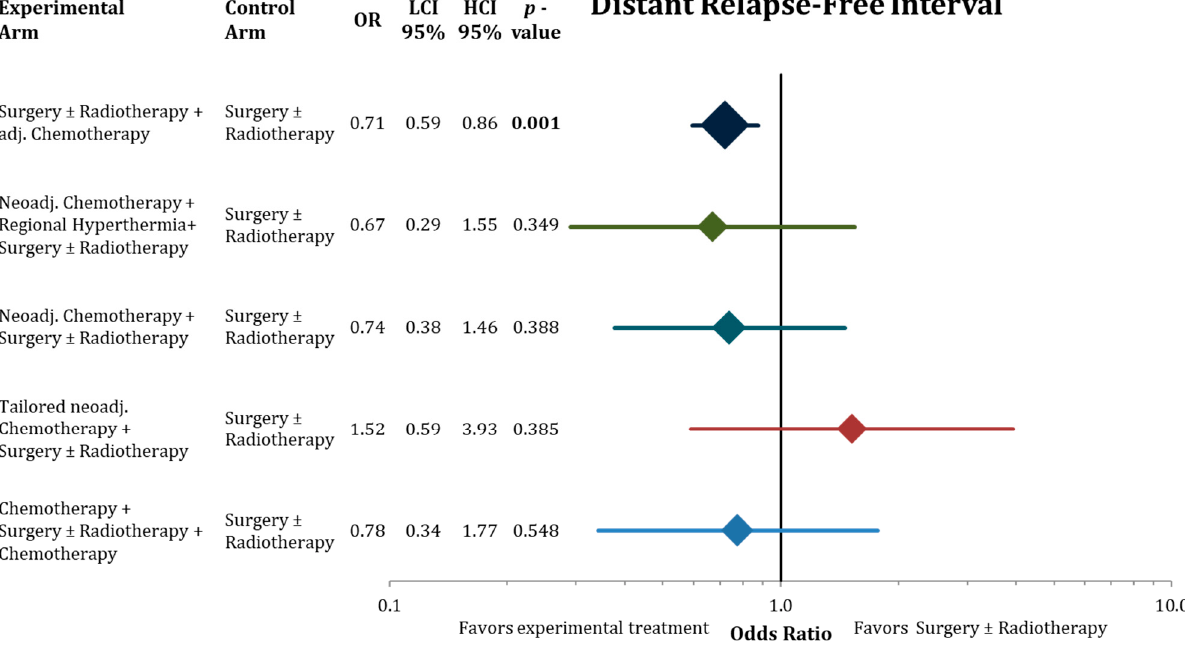
Figure 6. Forest plot comparing distant relapse-free interval in the network analysis of the experimental treatments against surgery ± radiation therapy. Hazard ratios with lower and higher 95% confidence interval and the corre- sponding p -values are presented. The sizes of the diamonds are proportional to the weights in the meta-analysis. HR = hazard ratio, LCI = lower limit of 95% confidence interval, and HCI = higher limit of 95% confidence interval. Bold values indicate significant p